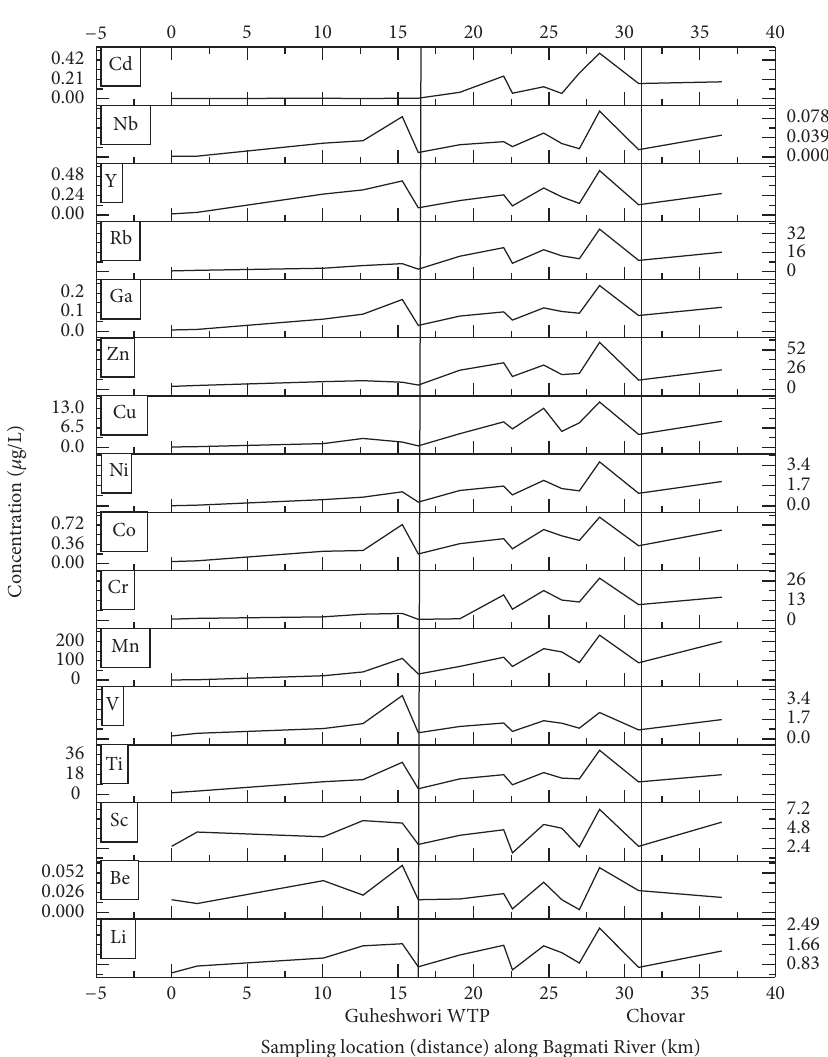
Figure 3: Changes in chemical composition of the Bagmati River from Sundarijal (headwater) to the area downstream (urban area) about 37 km at Khokana, within the Kathmandu Valley, where the concentration of elements is expressed in 𝜇 g/L.